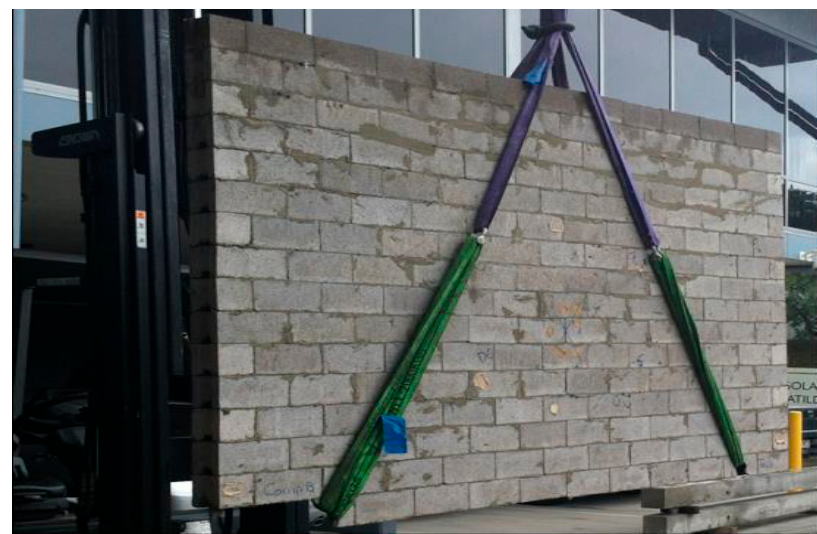
Figure 7. Lifting of TLM masonry walls made of concrete blocks [72].